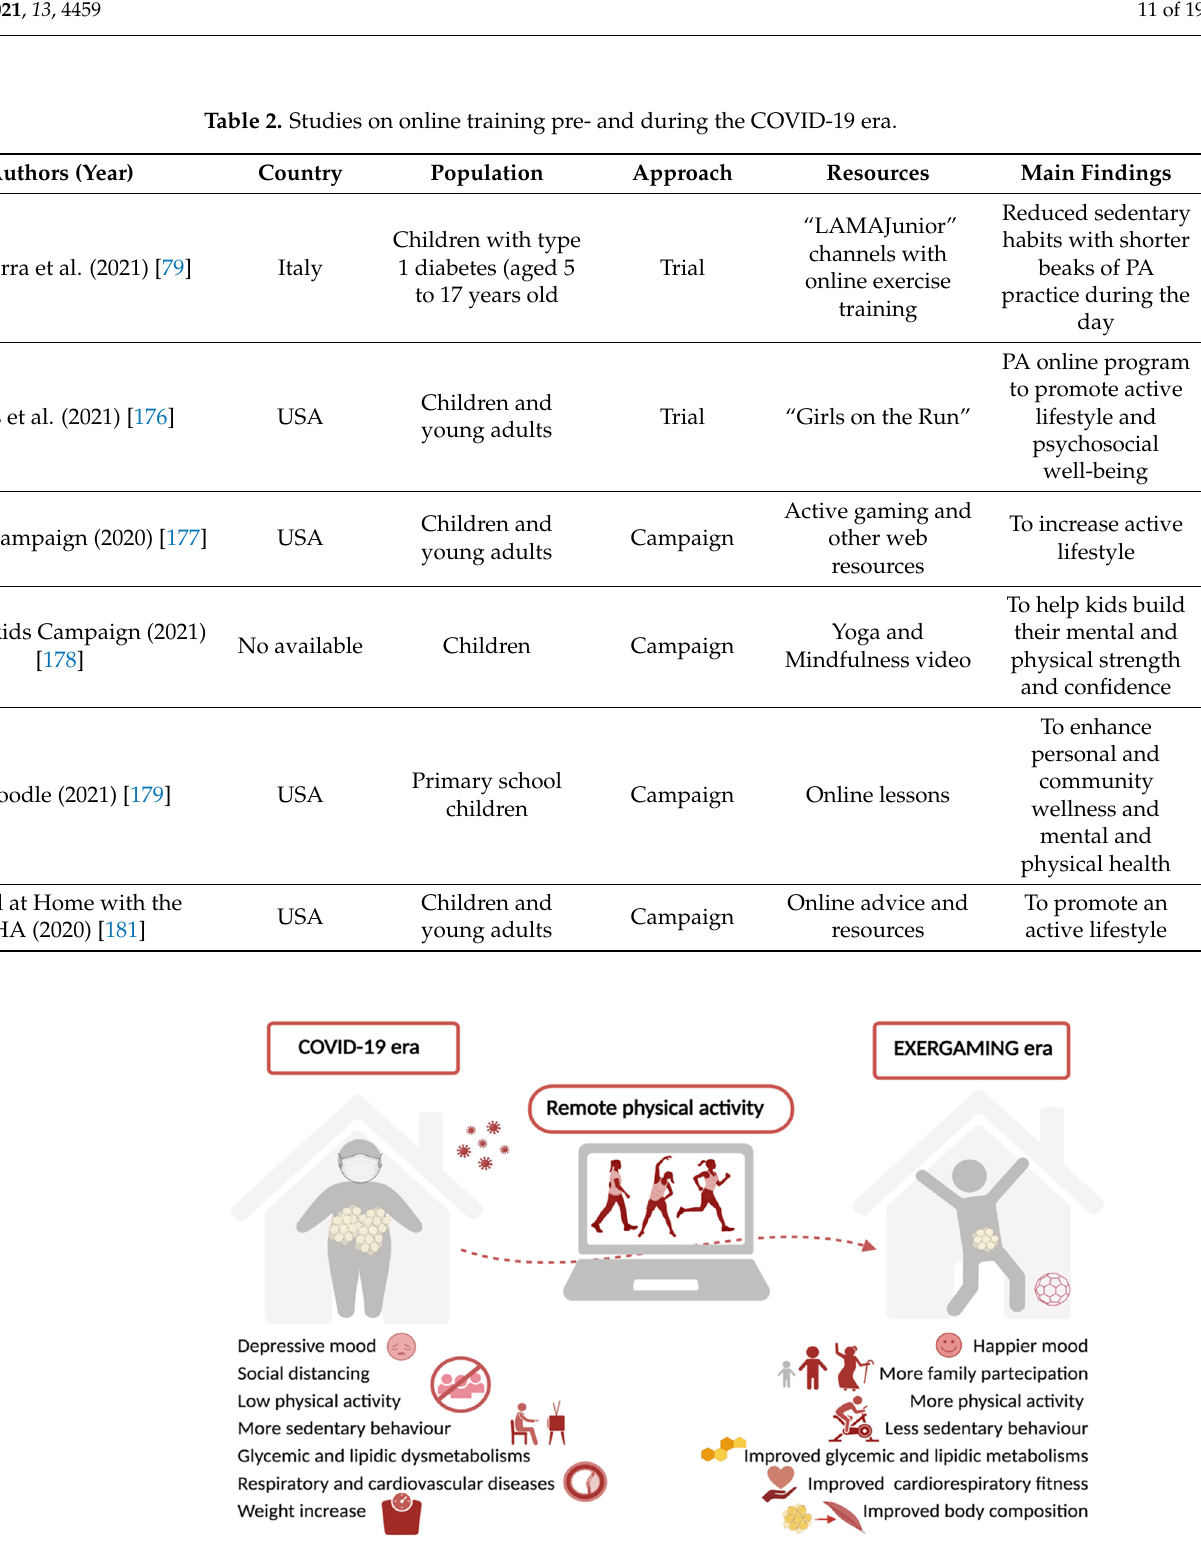
Figure 1. Beneficial effects of remote physical activity and exergaming during